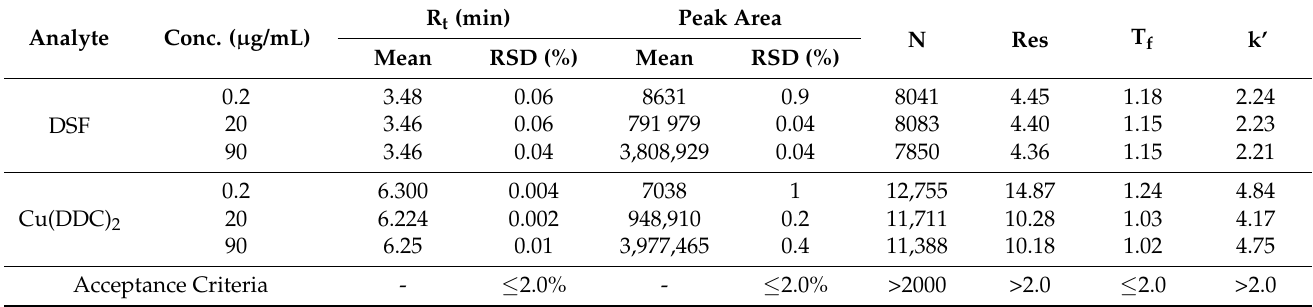
Table 8. System suitability testing for ruggedness evaluation, considering the reinjection of quality control samples (n = 6).